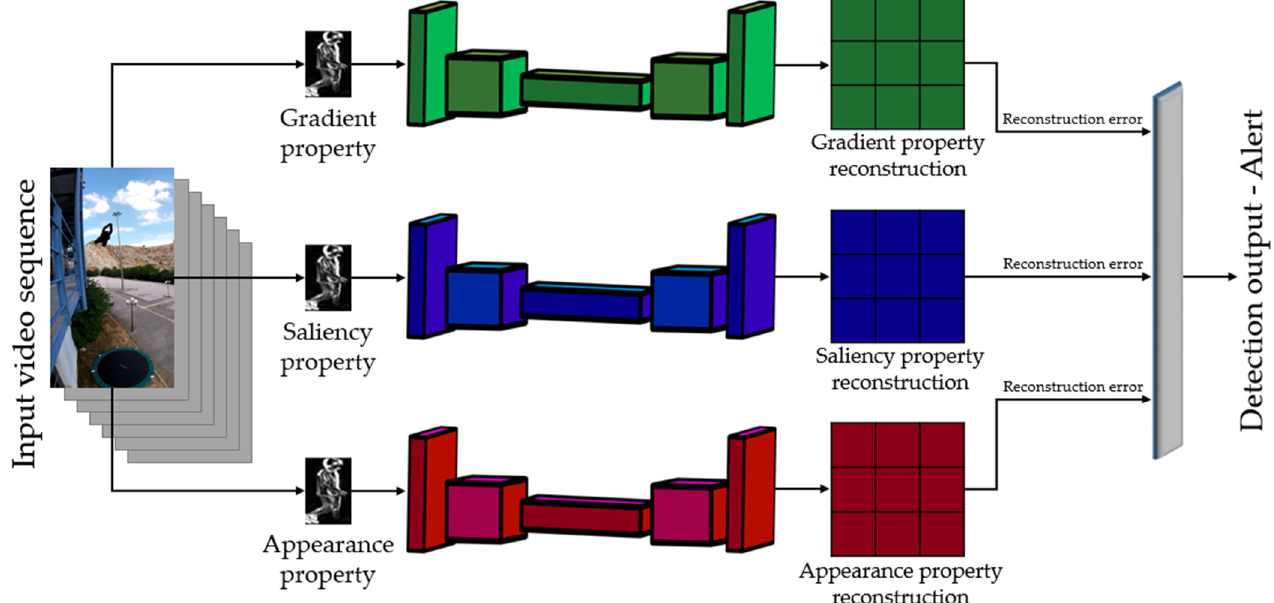
Figure 1. The overall system architecture, which utilizes a set of spatiotemporal convolutional autoencoders over multiple image properties of the RGB video sequences.